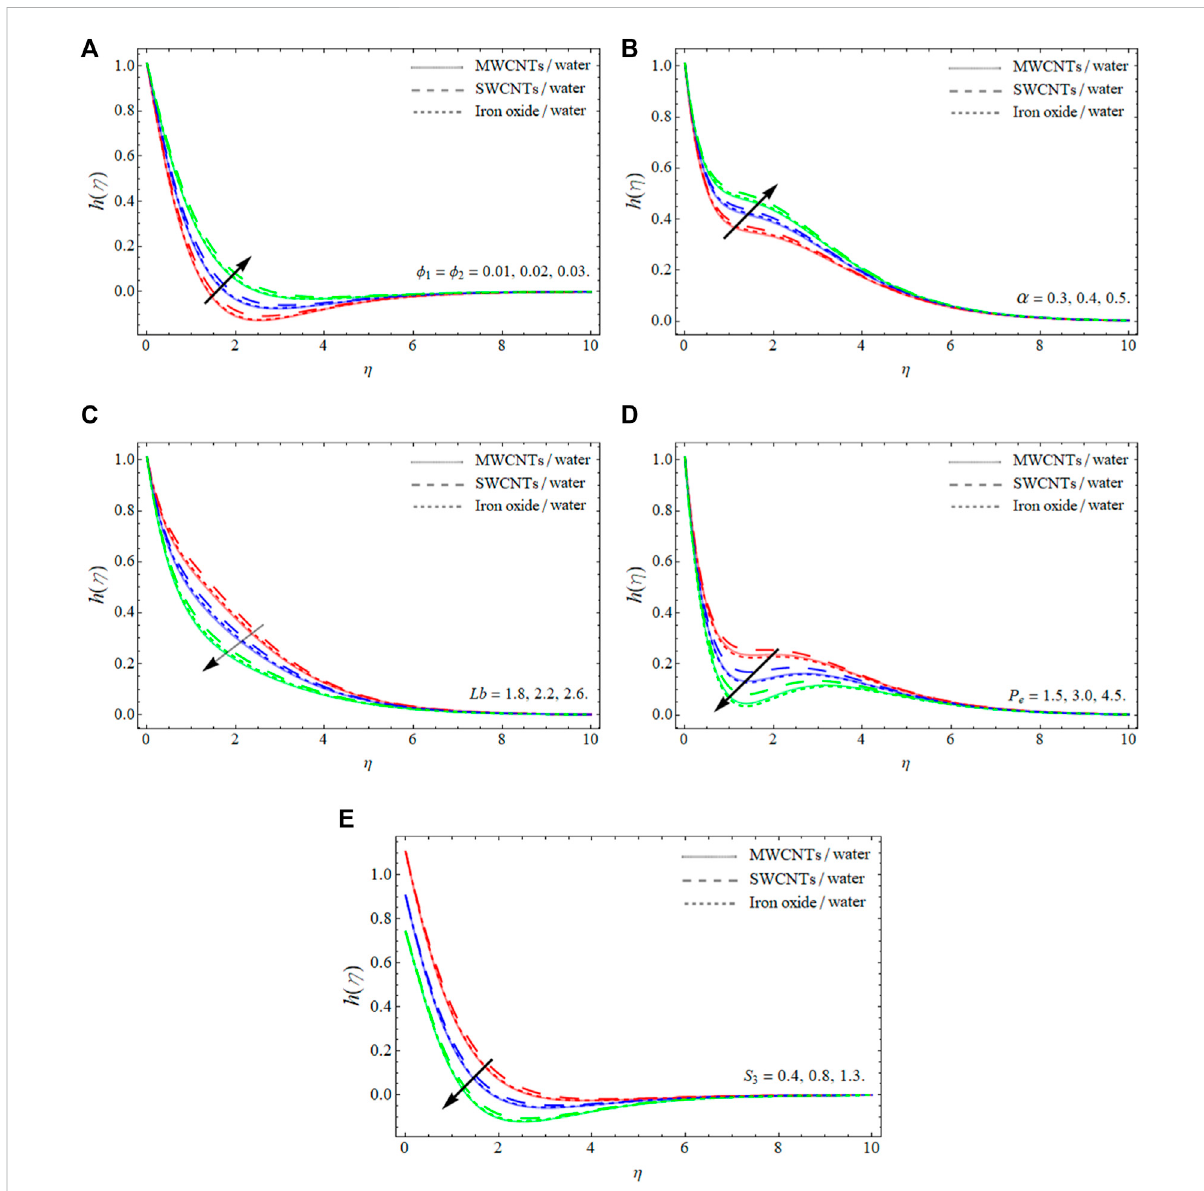
FIGURE 5 Effects of volume fraction ϕ 1 , curvature parameter α , bio-convection Lewis number Lb , Peclet number Pe, and themicroorganism strati fi cation parameter S 3 , on microorganism pro fi le h ( η ) .